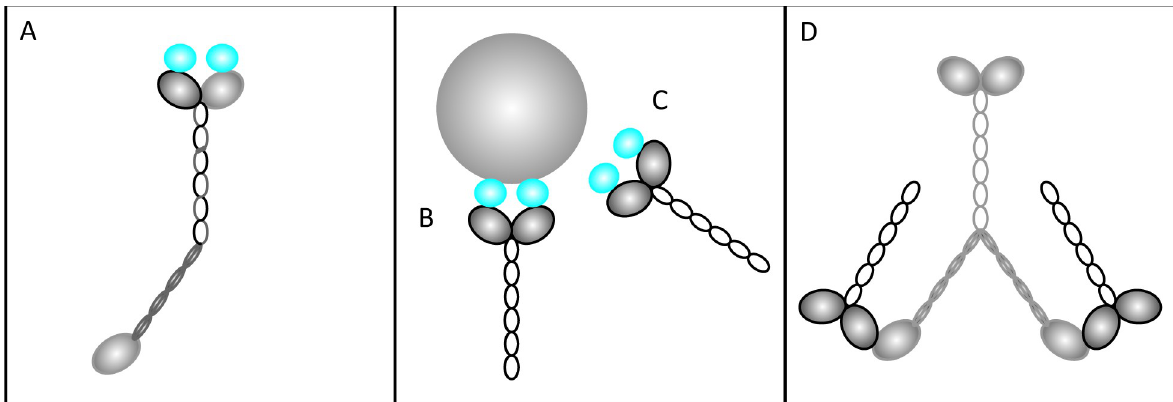
Fig 1. Schematic illustration of hypotheses for the dominant negative effect of truncated class XI myosins on organelle movement. (A) Myosin tails dimerize with endogenous myosins and form non-functional, “one-legged” dimers [38]; (B)-(C) Myosin tails block adaptor proteins at the cargo (B) or in the cytoplasm (C) [38]; (D) Myosin tails de-activate endogenous myosins by binding to their motor domains [40]. Endogenous myosins are depicted in light grey, truncated tails are shown in dark grey.